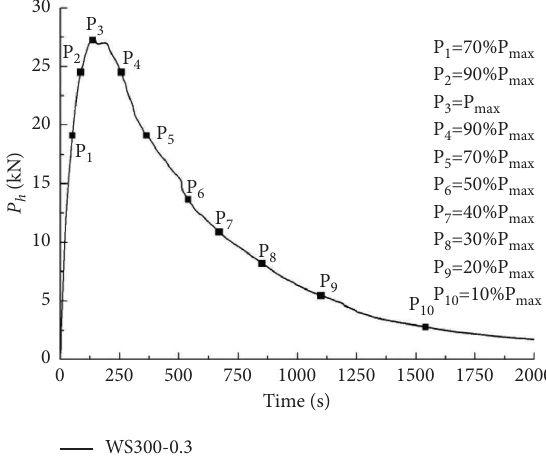
Figure 8: Typical loading stages of concrete during